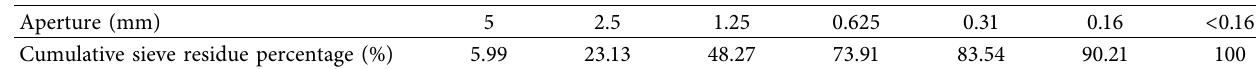
Table 8: Material grading table.